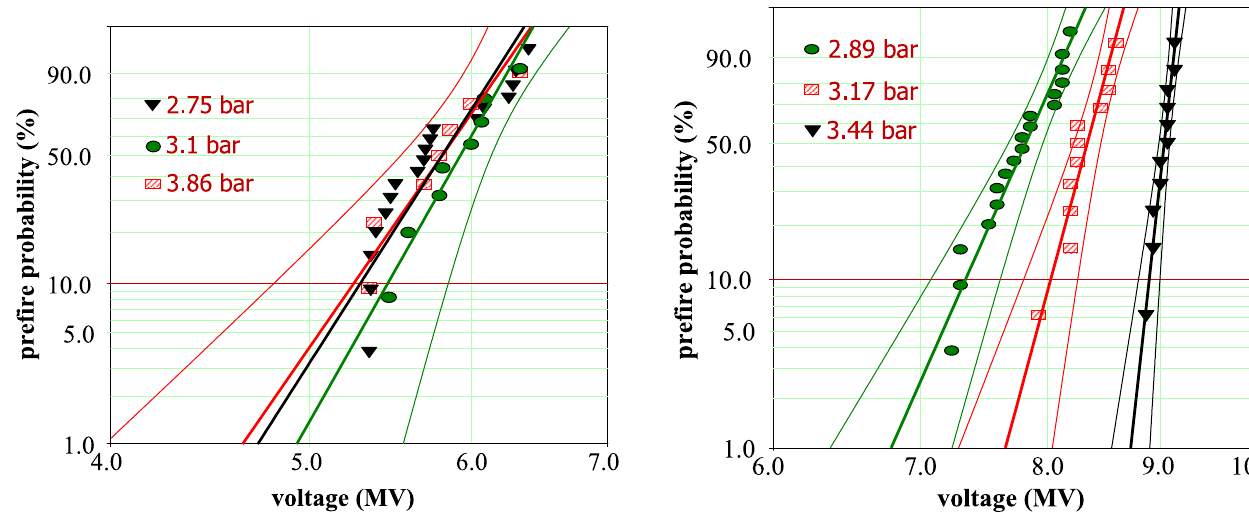
FIG. 11. (Color) Weibull analysis of self-closure data for the modified-Harrison profile utilizing HD-17 trigger